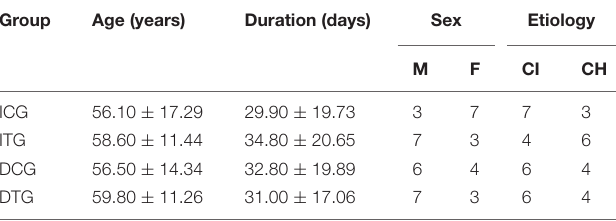
TABLE 1 | Participants’ characteristics across groups.